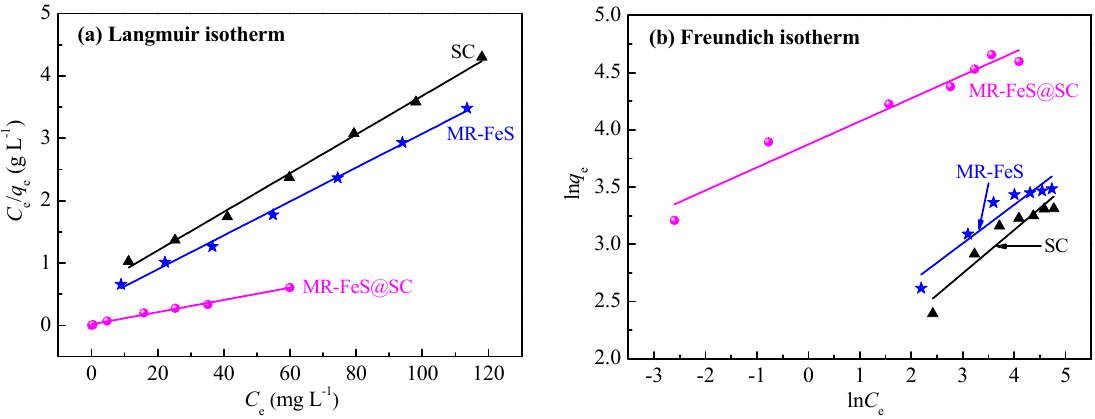
Figure 10. ( a ) Langmuir and ( b ) Freundlich isotherms for the adsorption of ST onto SC, MR – FeS, and MR – FeS@SC.